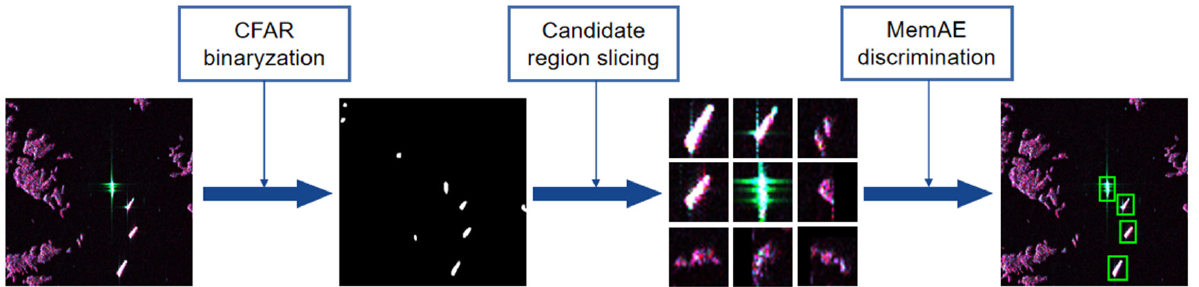
Figure 13. Overall detection procedures of our proposed method.